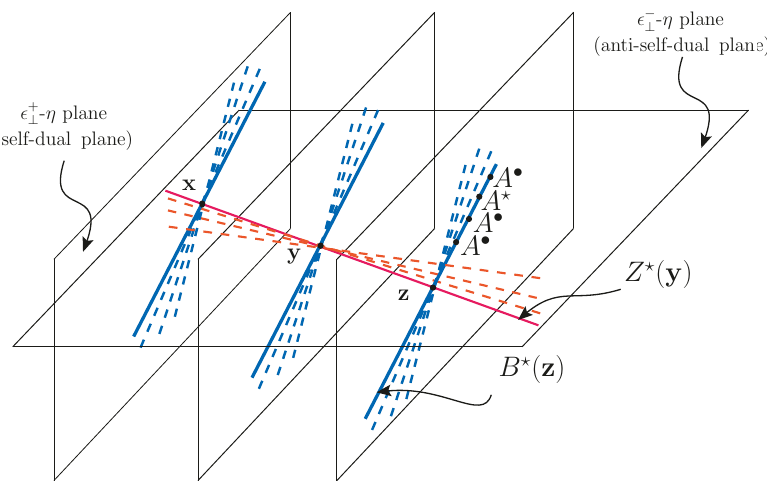
Figure 9 . Schematic presentation of the geometric structure of the Z ? field (the structure of Z • is quite similar). The vertical planes are the self-dual planes, i.e. the planes spanned by the vectors ε + = (0 , 1 , i, 0) and η = (1 , 0 , 0 , − 1) . The horizontal plane, in our terminology, is the anti-self-dual ⊥ plane, i.e. it is spanned by ε − = (0 , 1 , − i, 0) and η . The B ? fields (the minus helicity fields in the ⊥ MHV action) are the straight infinite Wilson lines on the self-dual plane, integrated over all slopes, and differentiated functionally to replace one plus gluon helicity field by the minus gluon helicity field. This structure is represented by the blue lines. The Z ? field, i.e. the minus helicity field in the new theory, is given by a similar Wilson line of the B ? fields, lying on the anti-self dual plane, and integrated over all